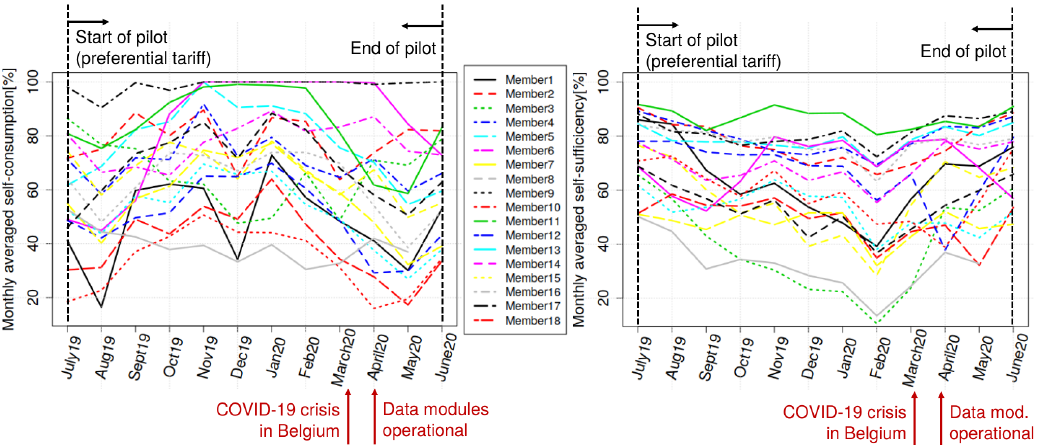
Figure 6. Monthly self consumption ( left ) and self-sufficiency ( right ) of the 18 members of the E-Cloud pilot. The preferential tariff became effective in July 2019, which started the pilot officially, and ended late June 2020. The data analytics modules developed in this work were effectively deployed on site in April 2020, during approximately 3 months.